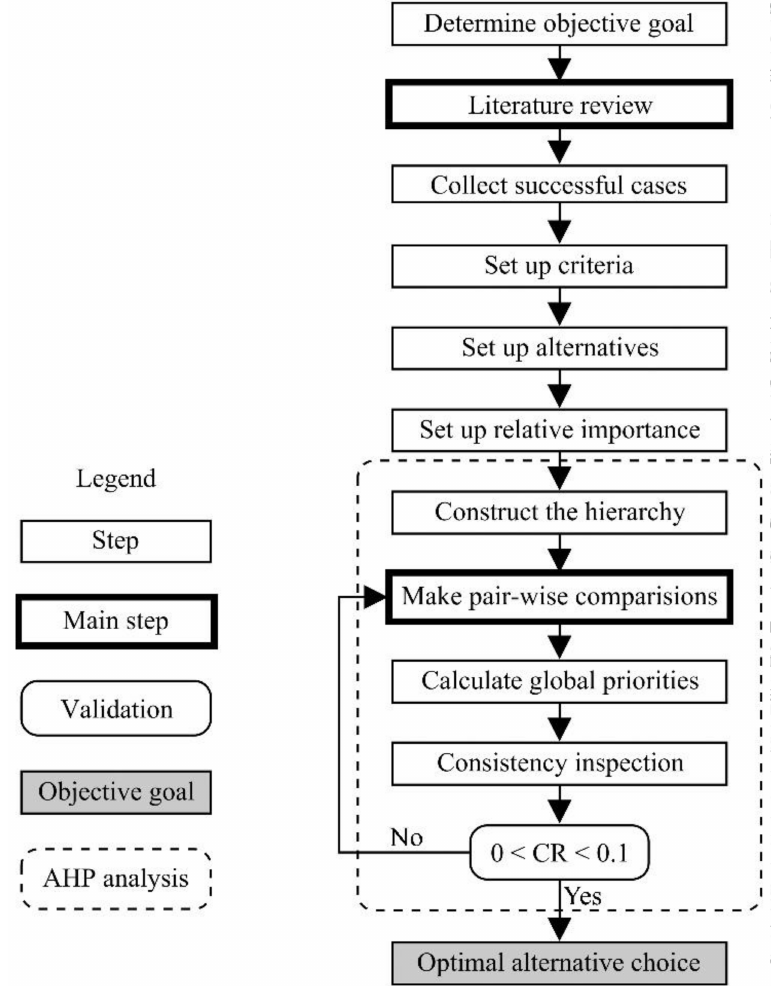
Figure 1. Decision-making model design. Source: Prepared by the